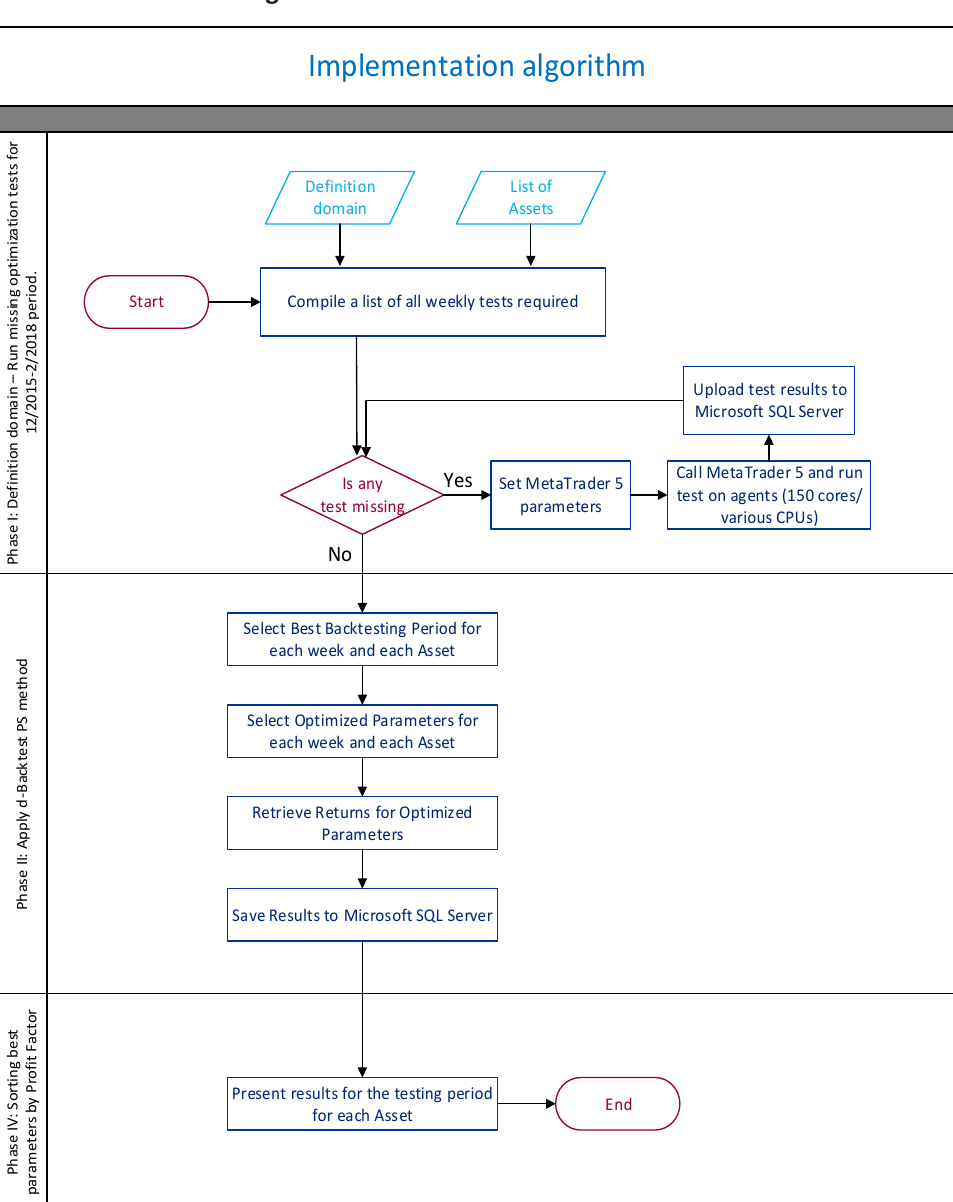
Figure 6. Test execution infrastructure